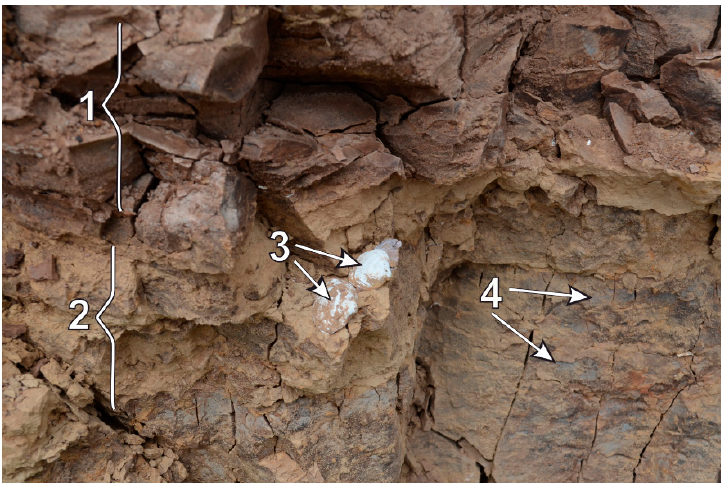
Figure 4. The facies of Chocolate clays: 1–mono clay layers of “Chocolate color”; 2–interlayers of thin yellow sands with mollusk shells; 3 and 4–gray fine silty coatings on the surface of fine prismatic structural units.